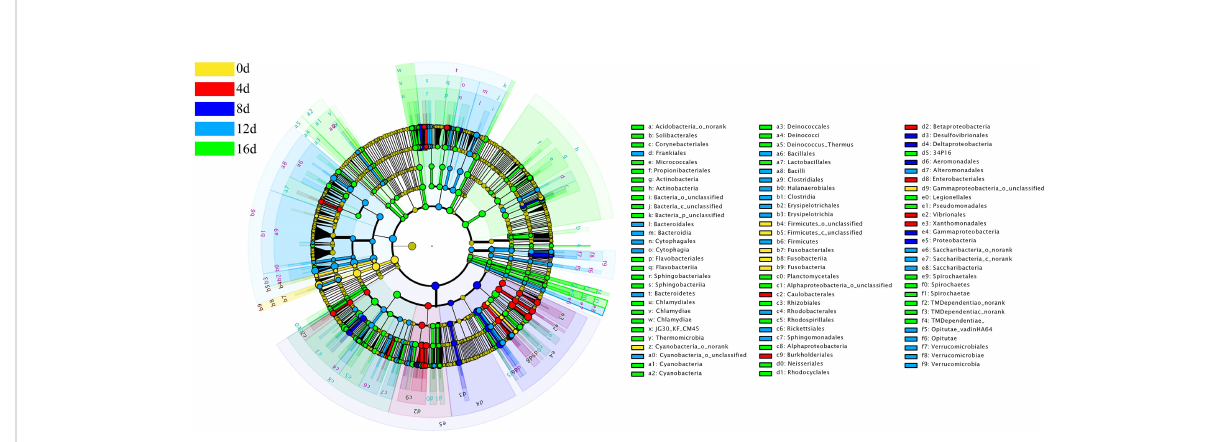
FIGURE 7 Cladogram illustrating the phylogenetic distribution of micro fl ora communities linked to the different durations of swimming exercise groups. LEfSe determined lineages with linear discriminant analysis (LDA) values of at least 4.0. The color of the class with the highest frequency represents differences. Yellow represents non-exercised group, red represents exercised for 4d group, blue represents exercised for 8d group, blue-green represents exercised for 12d group, and green represents exercised for 16d